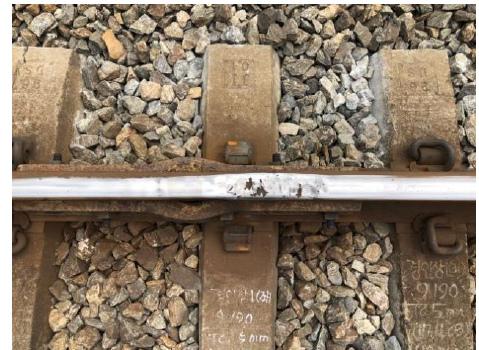
Figure 8. Weld section.